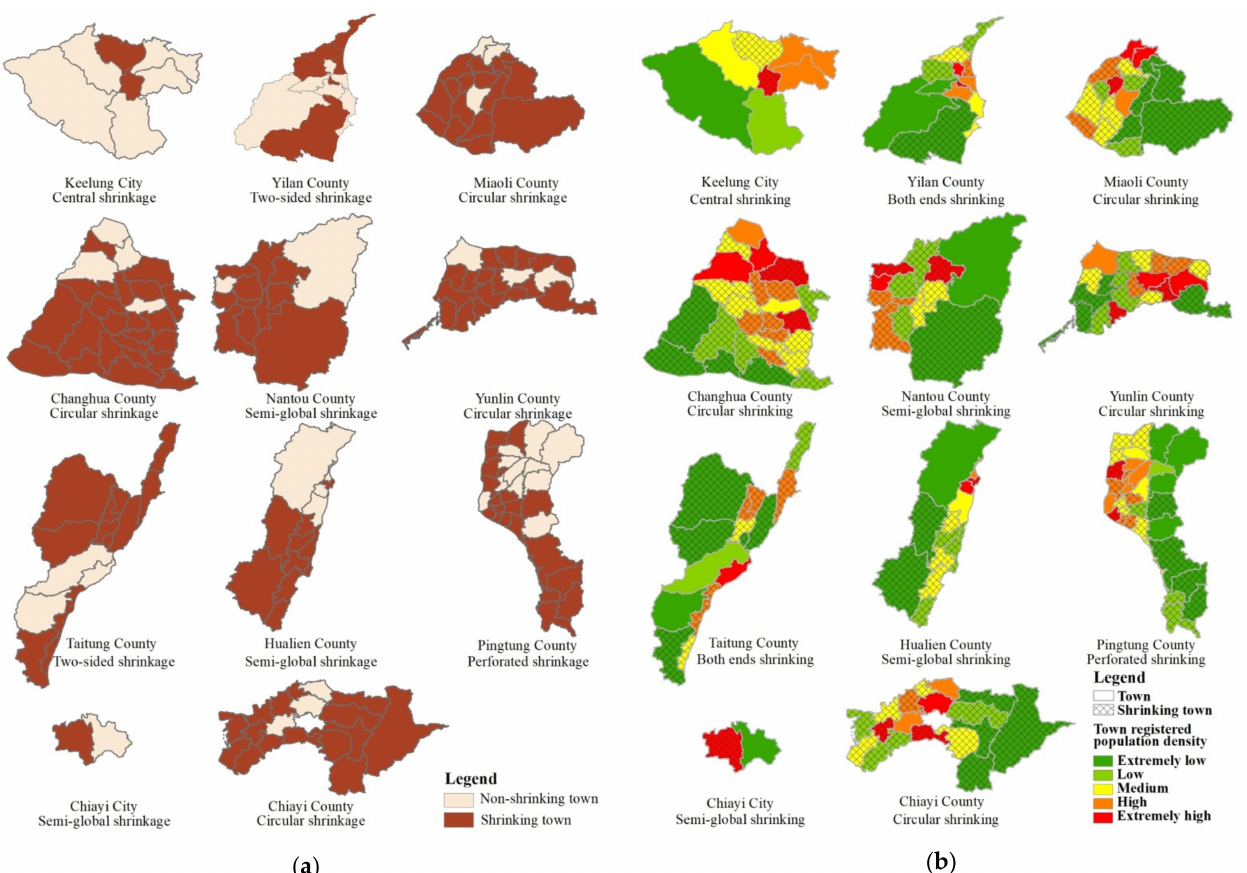
Figure 6. Spatial patterns of shrinkage: ( a ) spatial patterns of shrinking; ( b ) shrinkage and registered population